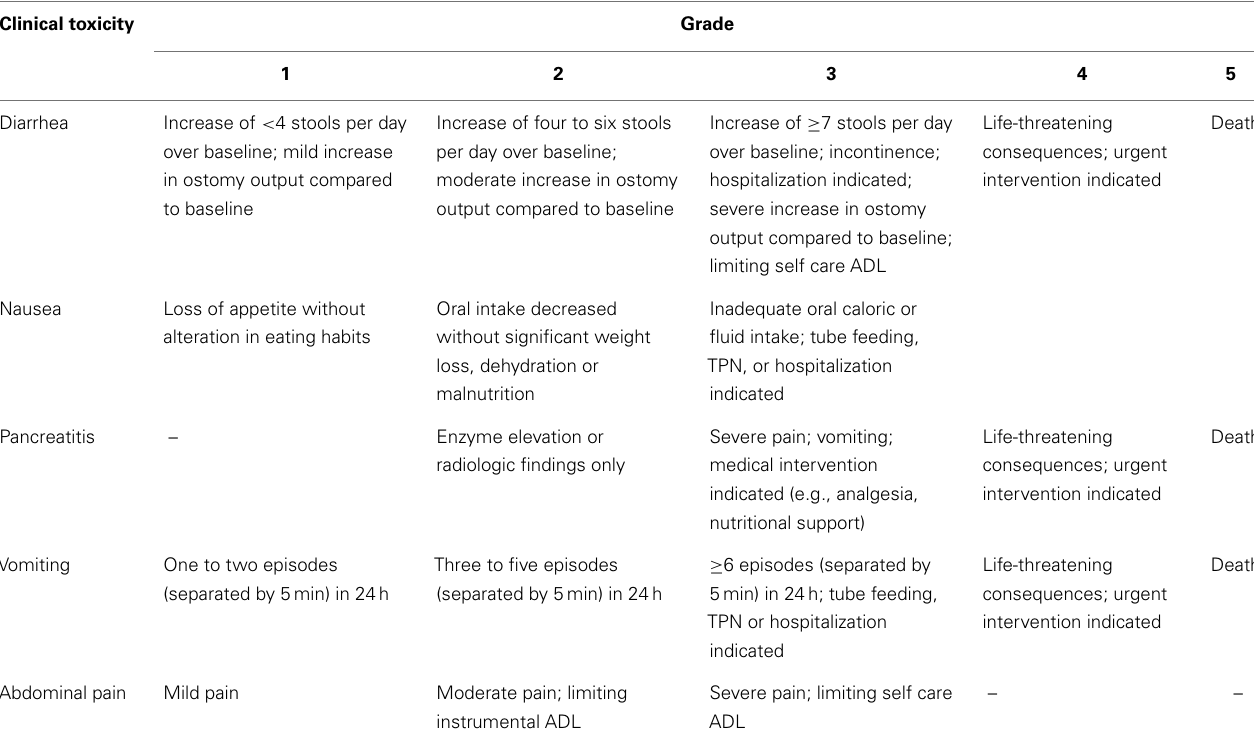
Table 3 | Some relevant clinical toxicities according to the CTCAE v4.0 .